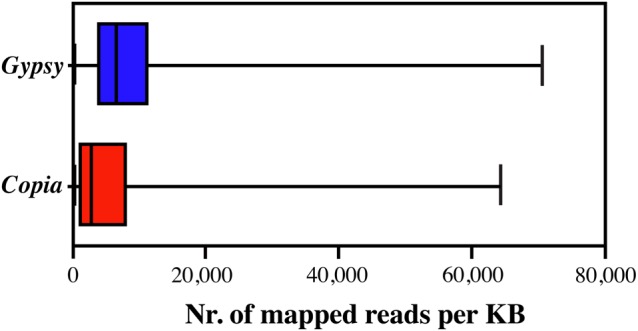
Box and whiskers plot of RE redundancy (calculated as the number of mapped reads per kb) of olive Copia and Gypsy REs. The boxes represent the 25–75%, whiskers represent the whole range of values, and lines in the box represent the mean values of the distribution.